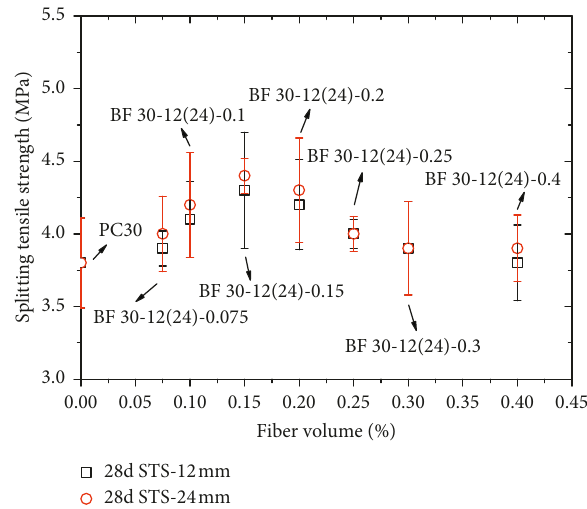
Figure 10: Effect of fiber volume fraction on splitting tensile strength (STS). Table 4: Crack length of test specimens with different fiber lengths.